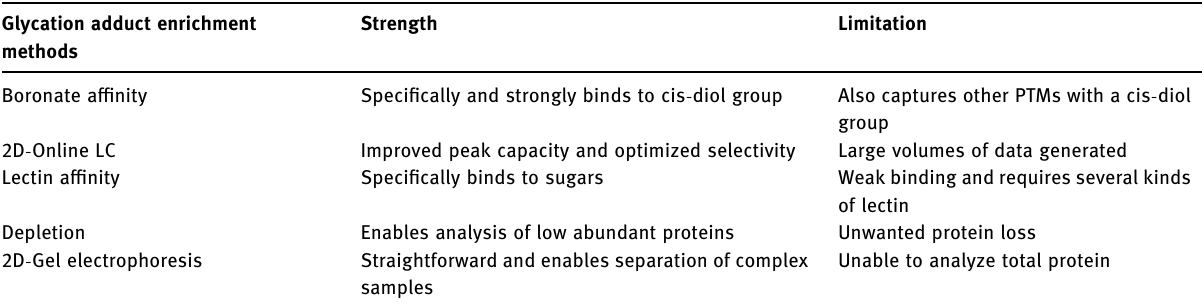
Table 1: Strengths and limitations of di ff erent enrichment methods for glycation adducts Glycation adduct